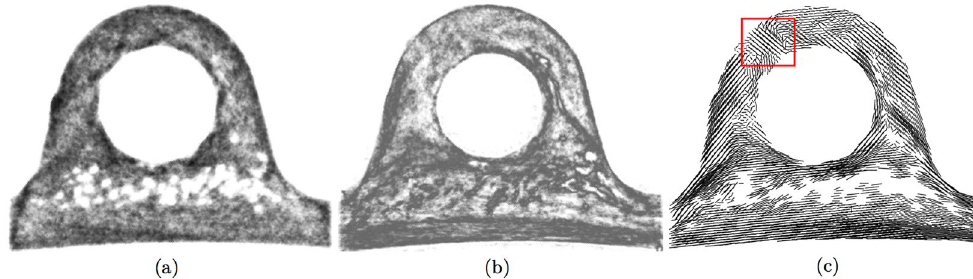
Figure 7. A slice of ( a ) the conventional CT volume, ( b ) the isotropic scattering component, and ( c ) the 3D vectors reconstructed using AXDT for a thermoplastic short fibre moulding sample measured at a spatial resolution of approximately 80 μ m. The red box marks a feature that cannot be seen in either of ( a ) or ( b